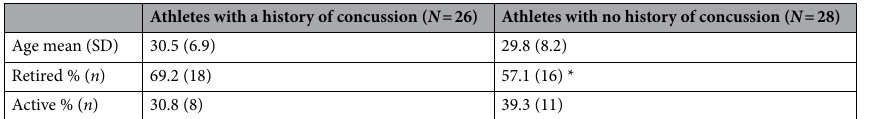
Athletes with a history of concussion ( N = 26) Athletes with no history of concussion ( N =